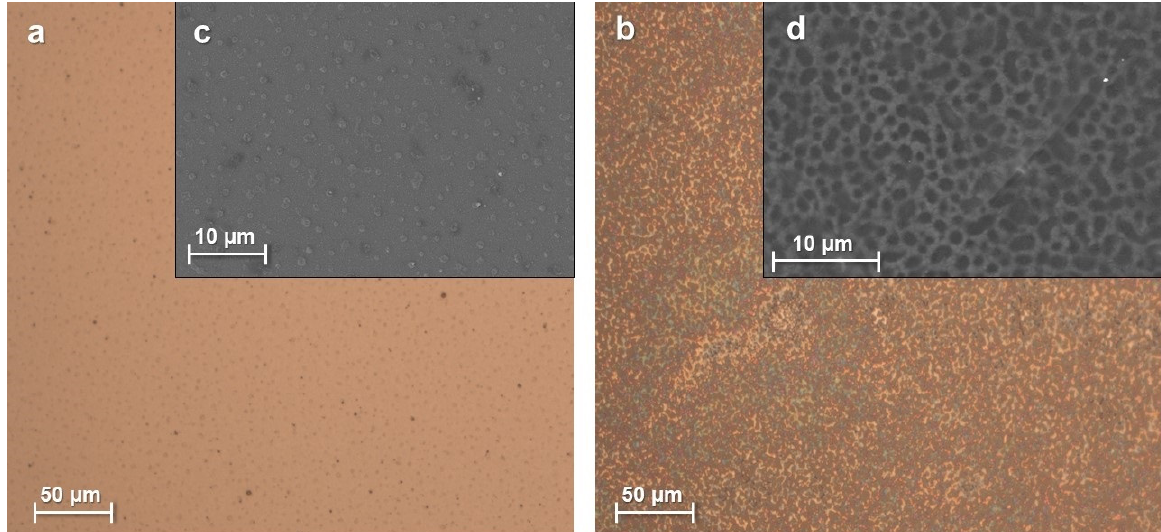
Figure 3. Image of PbSe film obtained using an optical microscope in a bright field of reflected light: ( a ) untreated, ( b ) after heat treatment. Image of PbSe film obtained using the SEM secondary electron detector: ( c ) untreated, ( d ) after heat treatment.